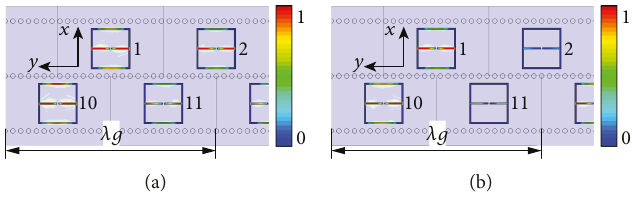
Figure 10: Simulated x component of electric fi eld distributions: (a) Con fi guration 1; (b) Con fi guration 2.